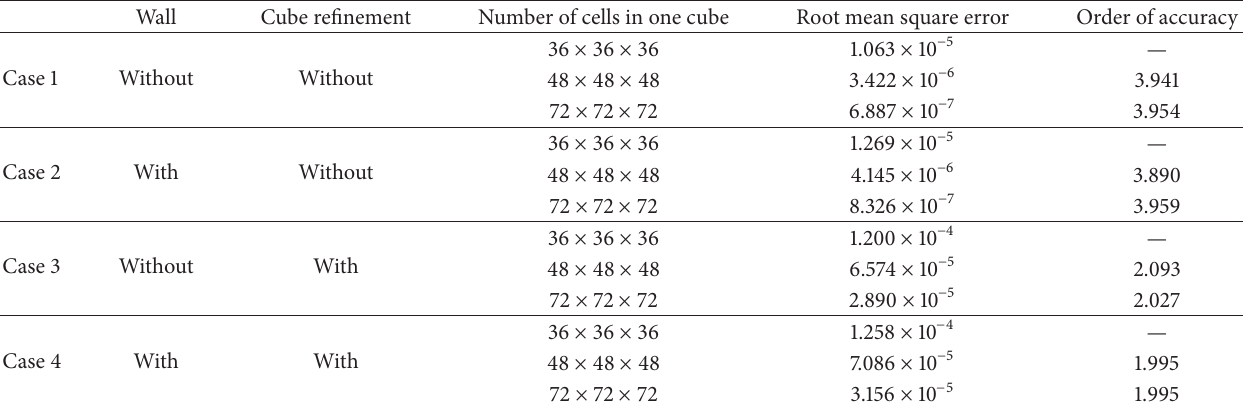
Table 1: Root mean square error and the order of accuracy.